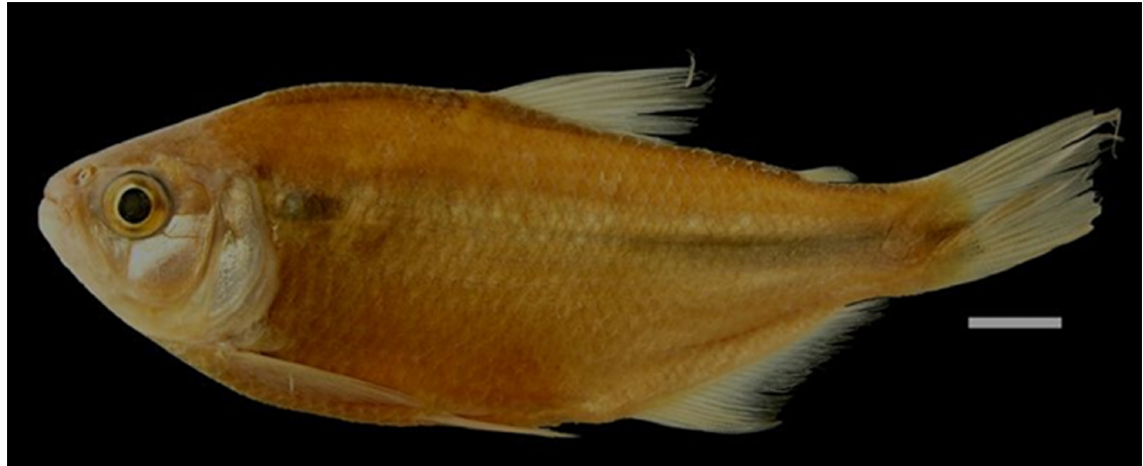
Fig. 6. Astyanax gandhiae sp. nov., holotype, 89.4 mm SL, Condorcanqui, Amazonas, Upper Cenepa River drainage (MUSM 46845). Scale bar =